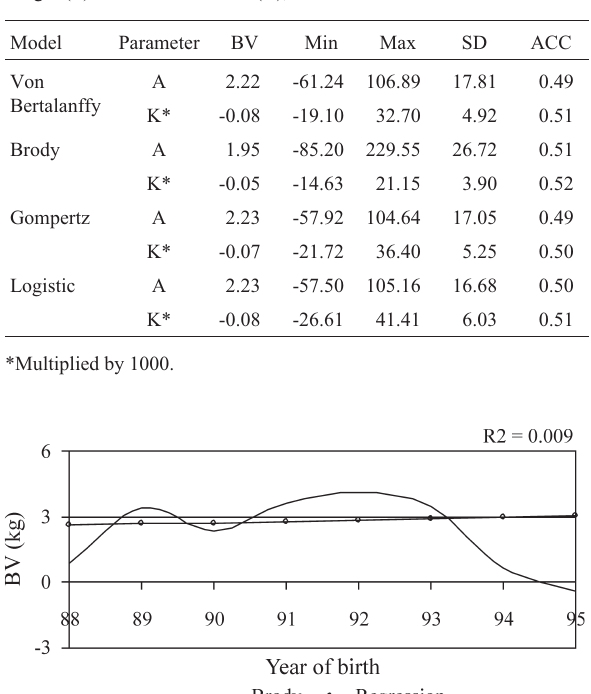
Table 1 - Mean breeding values (BV), minimum (Min) and maximum (Max) values, standard deviation (SD), accuracy (ACC) for asymptotic weight ( A ) and maturation rate (K), in the four models studied.